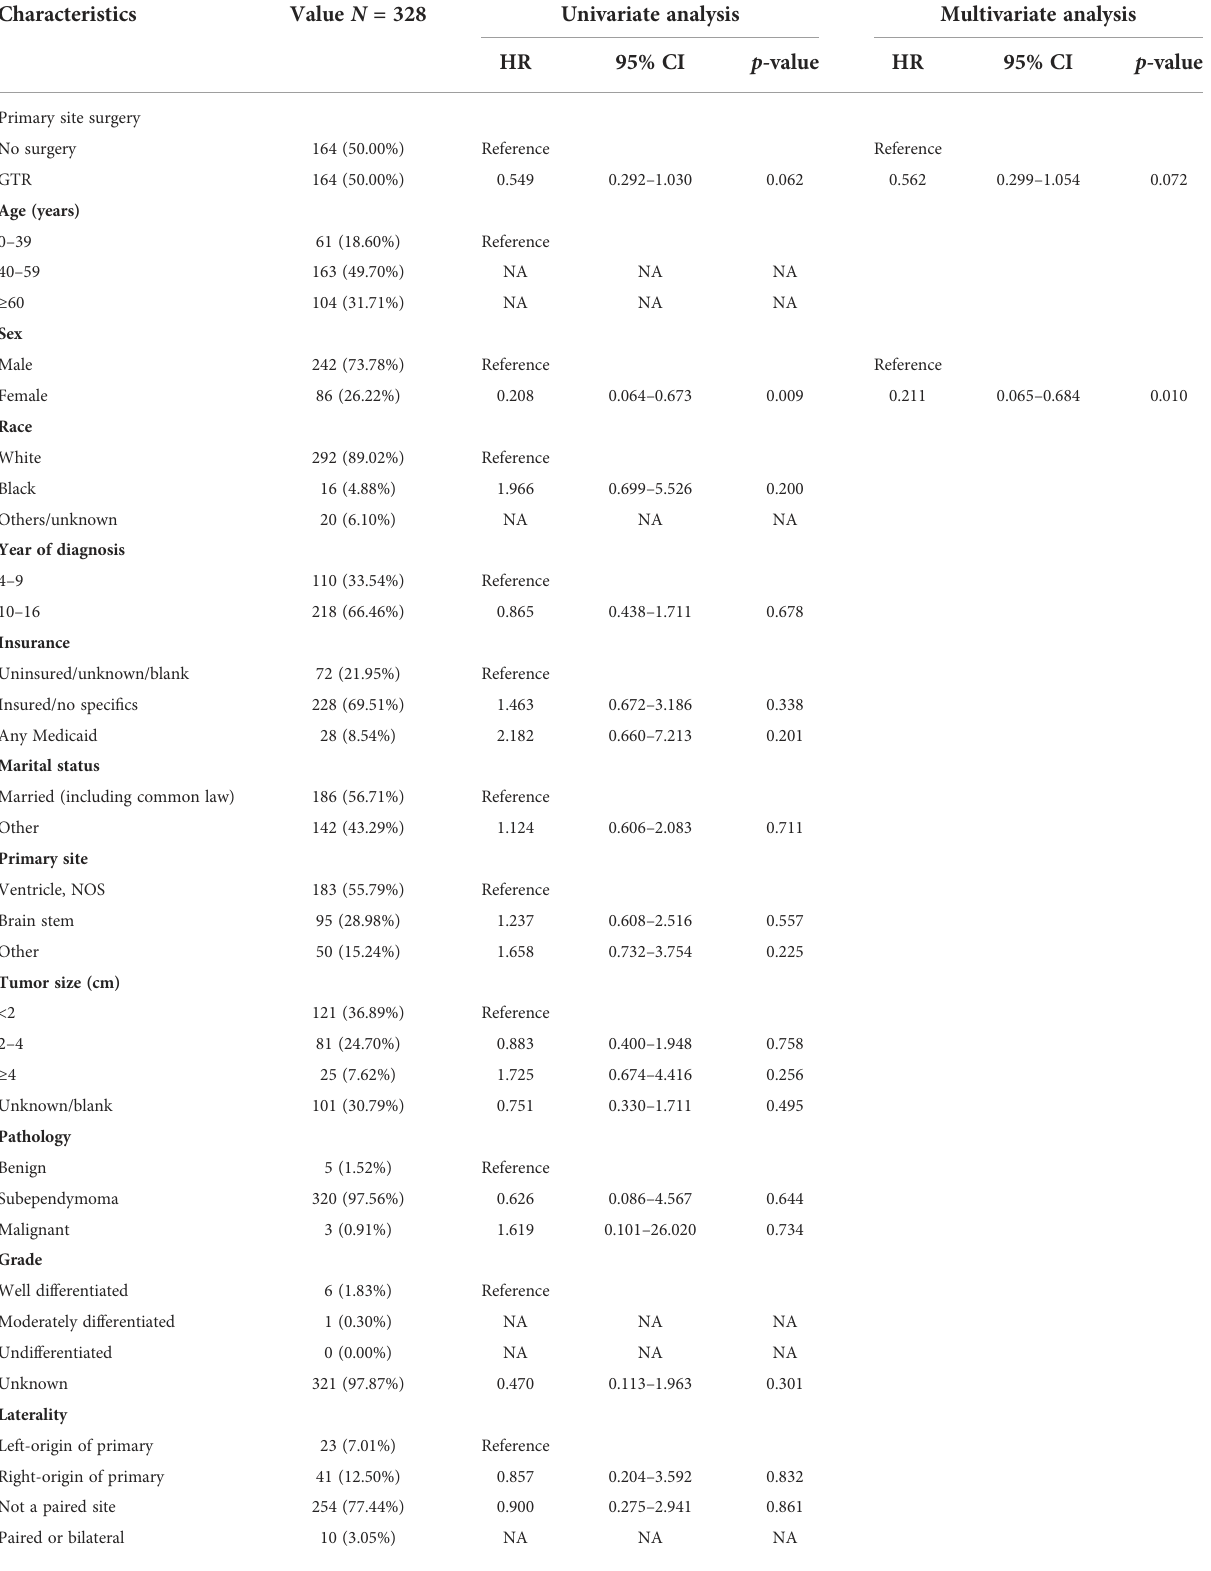
TABLE 4 The characteristics of 328 patients from the 470 patients grouped according to no surgery and GTR after